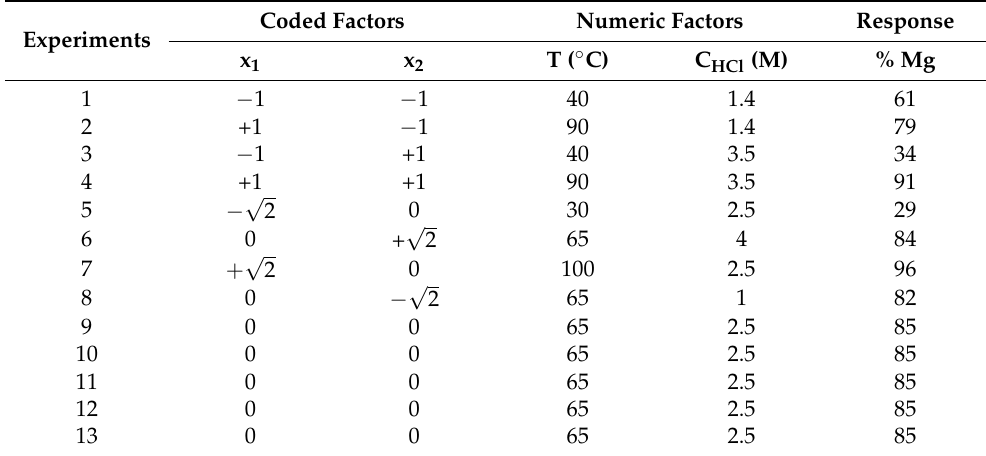
Table 5. Experimental conditions and Mg